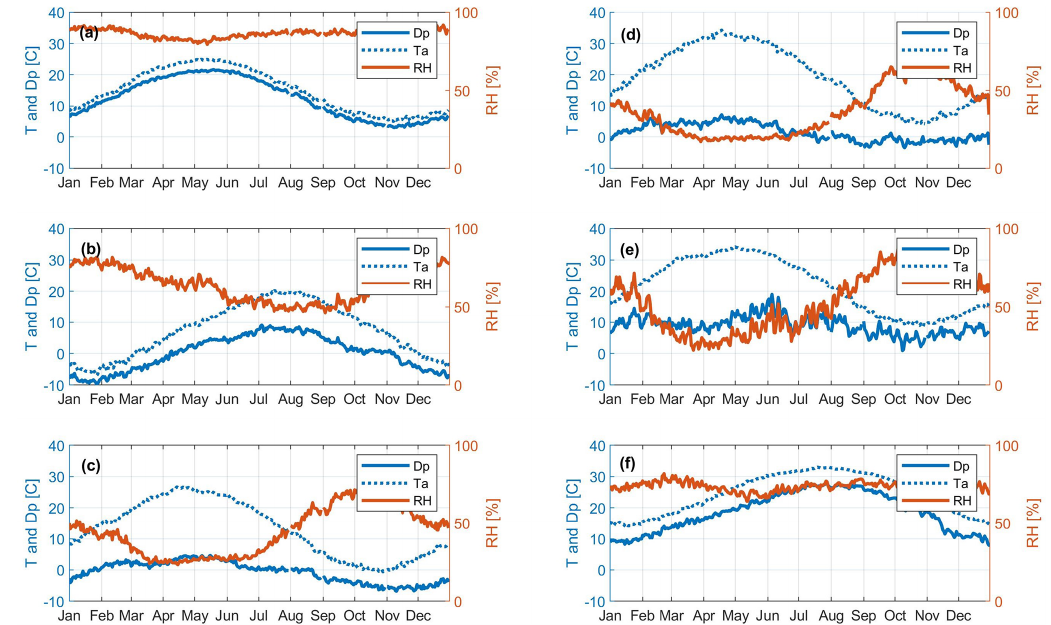
Figure 7. Nighttime (i.e., 18:00, 21:00, 00:00, 03:00LT) long-term mean (1980–2010; 30 years) of dew point temperature ( D p ) temper- ature ( T a ), and relative humidity in six selected stations located in dew zone A–F. (a) Ramsar (dew zone A); (b) Zanjan (dew zone B); (c) Isfahan (dew zone C); (d) Tabas (dew zone D); (e) Ahvaz (dew zone E), and (f) Bandar Abbas (dew zone F). Data were obtained from the meteorological organization of Iran.